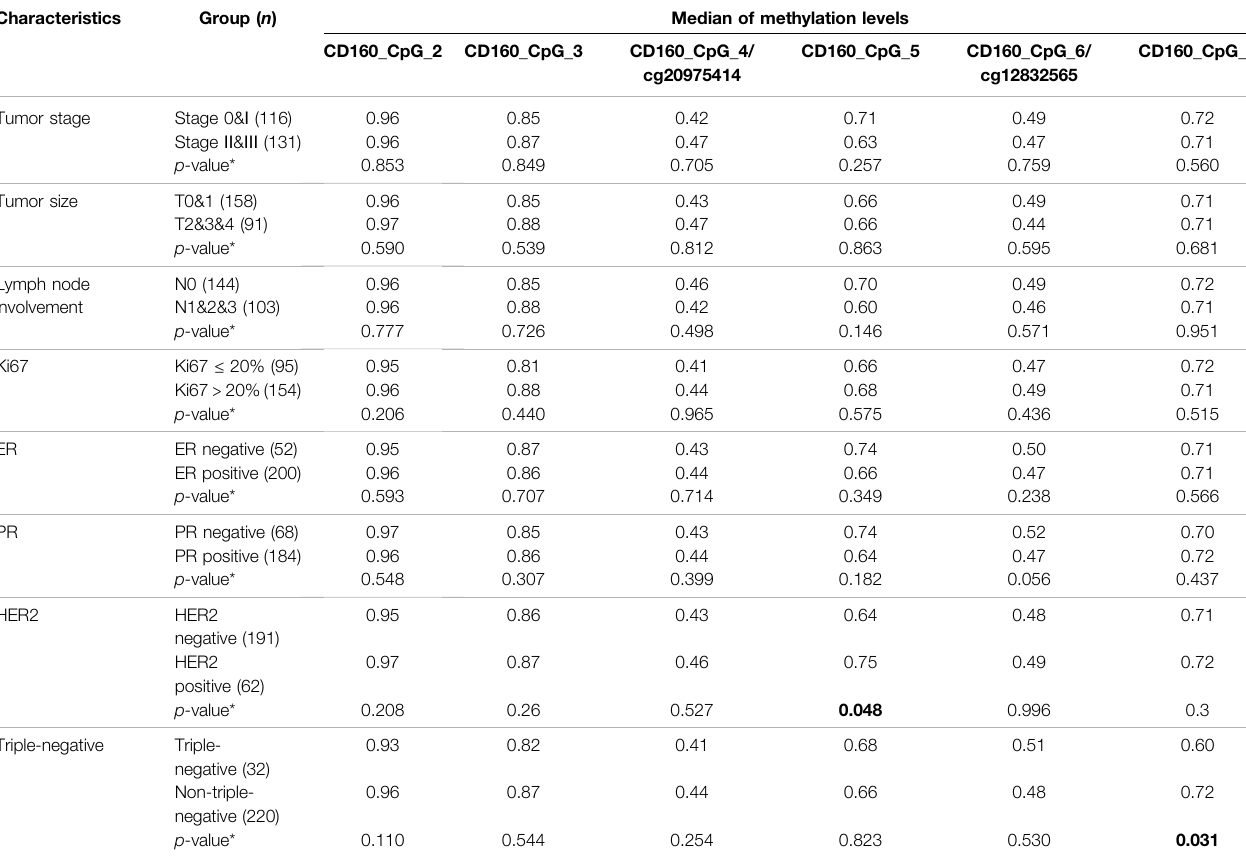
TABLE 4 | Correlation between CD160 methylation and the clinical characteristics of sporadic BC cases combining validation I and validation II. Characteristics